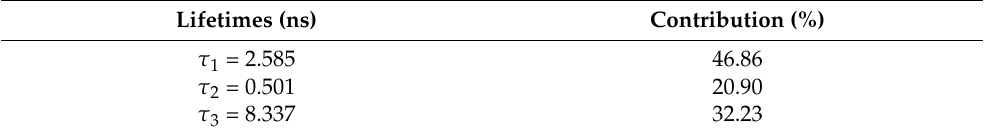
Table 4. Recorded excited states’ lifetimes.